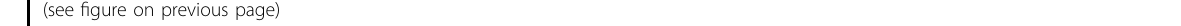
Fig. 5 RNA Pol III subunits are substrates of tPARP1. a POLR3B, POLR3F, and POLR3G are identi fi ed as substrates of tPARP1. Individual subunits of Pol III with myc tag was expressed in U2OS cells, followed by poly(dA-dT)-stimulated apoptosis. Anti-ADPr antibody was used for IP; and the complex was analyzed by western blotting with anti-myc antibody. b POLR3B, POLR3F, and POLR3G are substrates of tPARP1 in vitro. Auto-ADP-ribosylation was detected by anti-ADPr antibody (upper panel). Recombinant protein in each reaction was also examined by the SDS-PAGE with Coomassie blue staining (lower panel). c ADP-ribosylation of POLR3B, POLR3F, or POLR3G was examined in U2OS cells treated with or without 1 µM olaparib for 1 h. d ADP-ribosylation of POLR3B, POLR3F, or POLR3G was examined in wild-type and PARP1 knockout U2OS cells. e ADP-ribosylation of POLR3B, POLR3F, or POLR3G was examined in U2OS cells expressing wild-type or caspase 3-resistant (D214N) PARP1. Note that the cells were harvested after 6-h treatment with 5 μ g/mL poly(dA-dT) in a , c – e